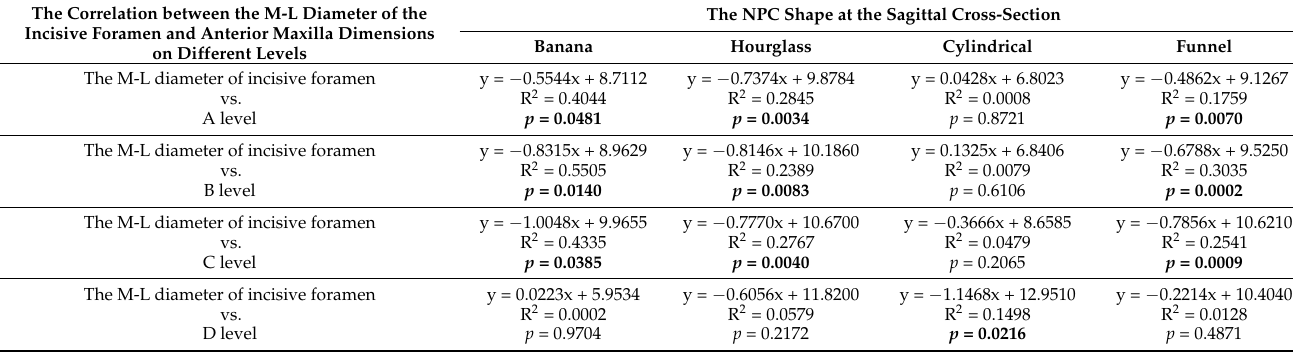
Table 3. The correlation between the M-L diameter of the incisive foramen and anterior maxilla dimensions at predefined portions depending on the canal shape at the sagittal cross-section. The NPC Shape at the Sagittal Cross-Section Banana Hourglass Cylindrical